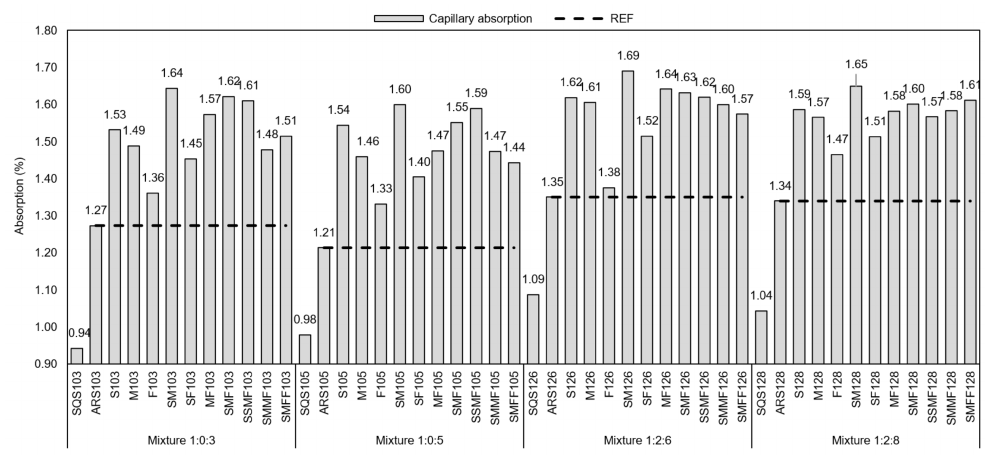
Figure A6. Capillary